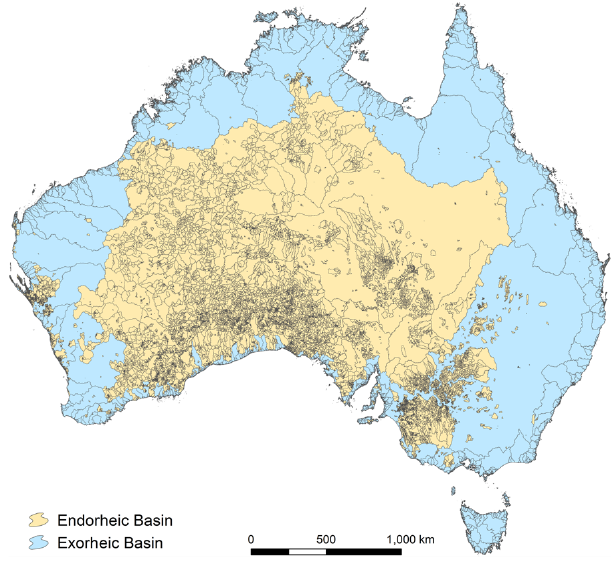
Figure 5. Drainage basins delineated from the 9s